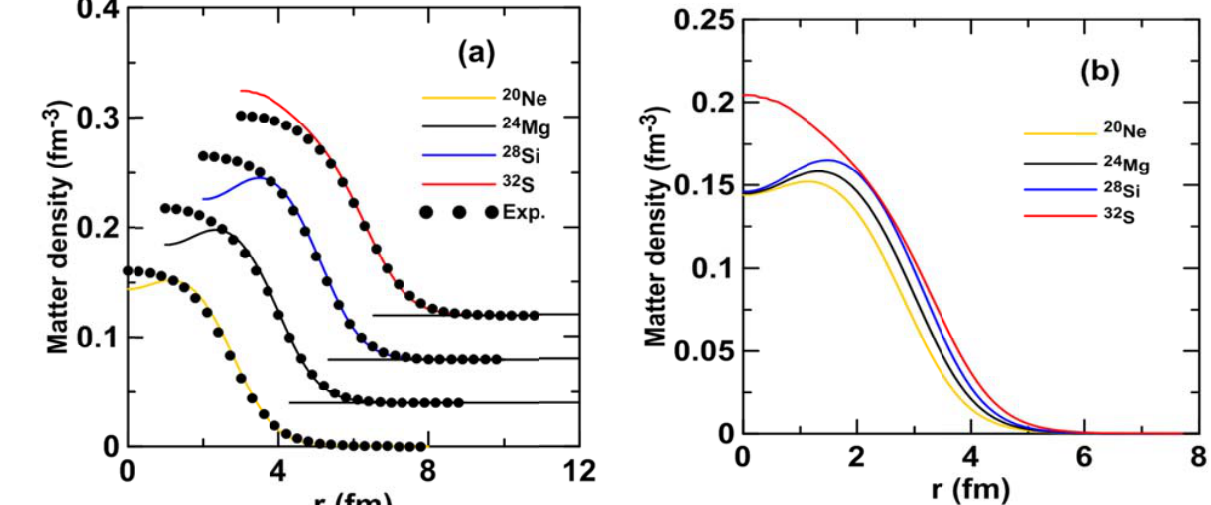
Fig. SKx and data